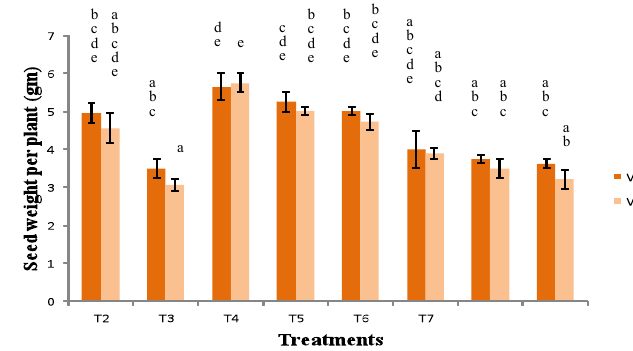
Fig. 5C: Effect of Azospirillum inoculation on seed weight per plant of two canola varieties (v1 and v2) grown under drought stress. Where, To = Un-inoculated and well watered, T = Un-inoculated and drought exposed, T2 = Seed inoculated and well watered, T3 = Rhizosphere inoculated and well watered, T4 = Seed inoculated with heat killed inoculums and well watered, T5 = Seed inoculated and drought exposed, T6 = Rhizosphere inoculated and drought ex- posed, T7 = Seed inoculated with heat killed inoculums and drought exposed. And V1 = Rainbow, V2 = Con II.